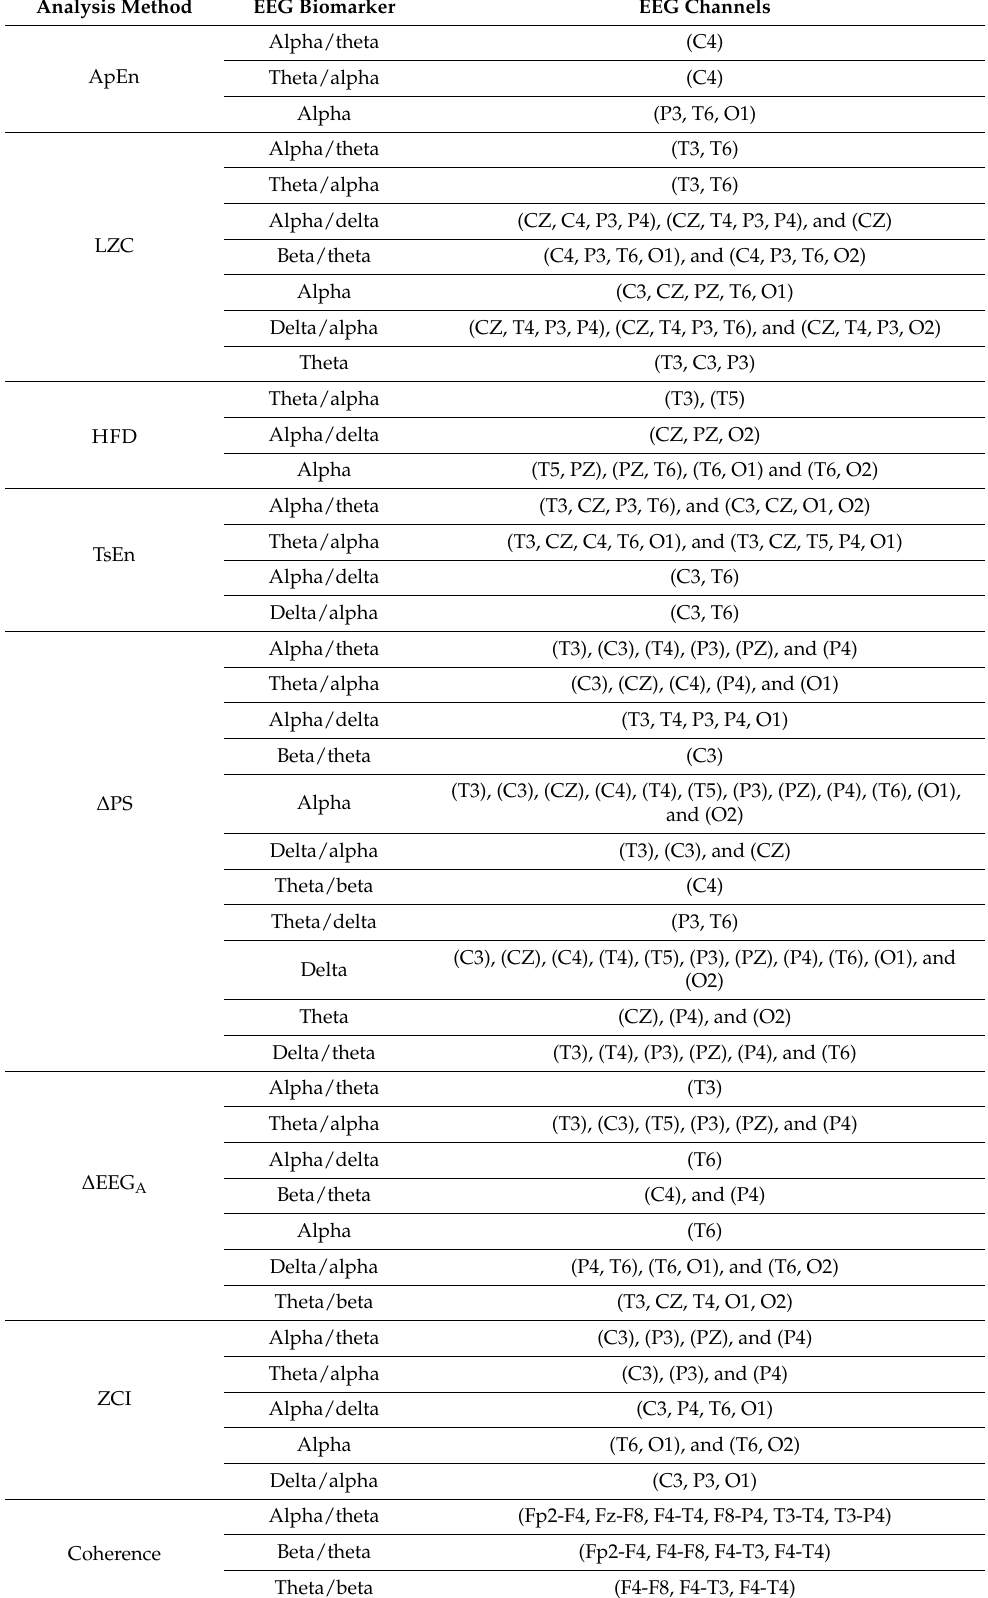
Table 6. The best performance of EEG biomarkers for the investigated eight